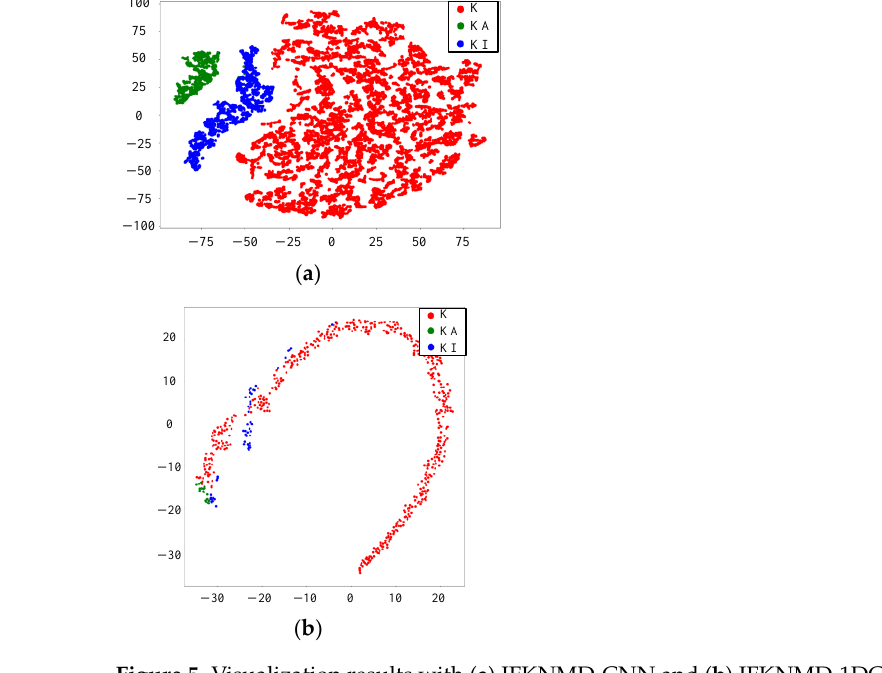
ROC curve of 1D-CNN (AUC = 0.87) ROC curve of IFKNMD-1DCNN (AUC = 0.97) ROC curve of IFKNMD-CNN (AUC = 1.00)